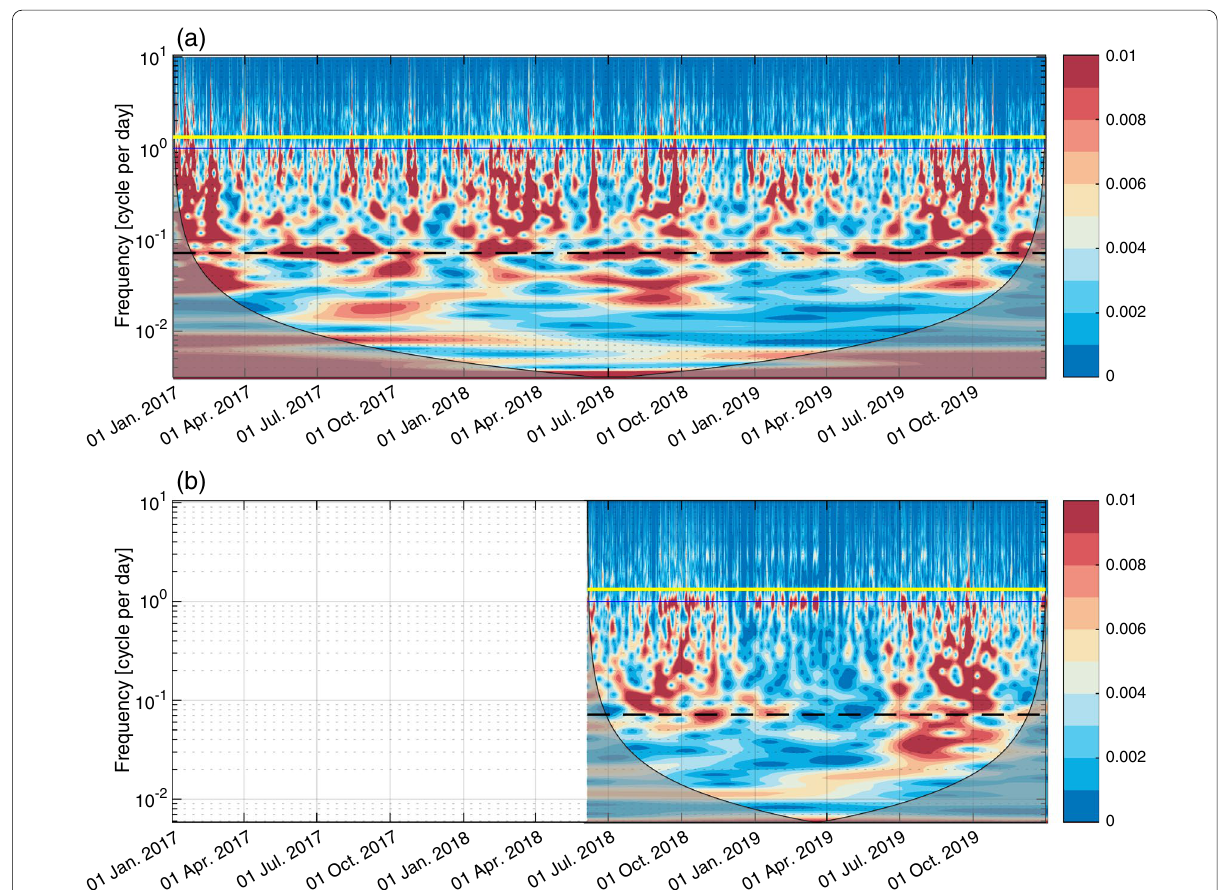
Fig. 7 Wavelet transform of the axis of the Tsugaru Warm Current at 141.3°E calculated from a the high-frequency radar data and b the JCOPE-T DA data. The yellow line indicates the inertial frequency at 41.5°N, 1.26 cycles per day (periods of 0.75 days). The blue and black lines denote 1 and 0.07 cycles per day (periods of 1 and 14 days),